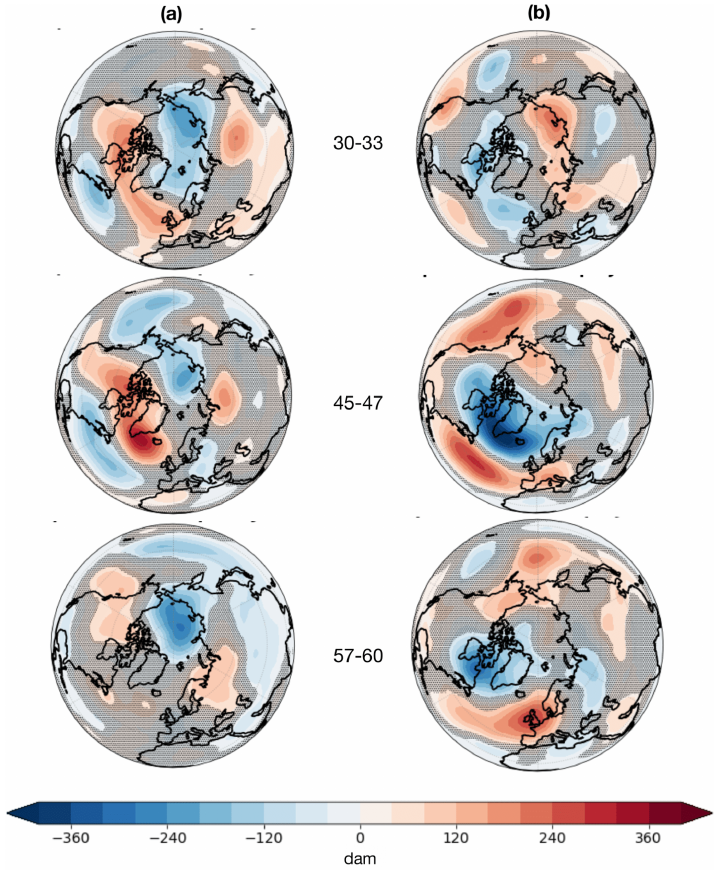
Figure 12. Same as in Fig. 11, for